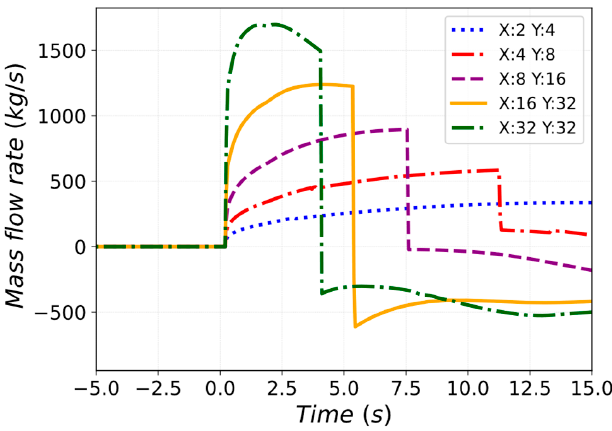
Figure 21. Mass flow rate net balance of PHTS area.